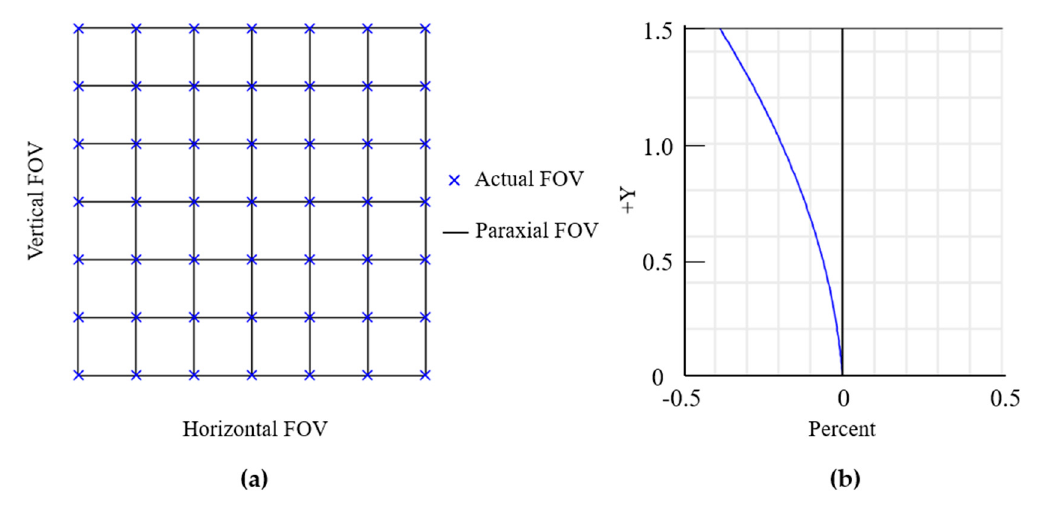
Figure 16. Distortion of the off-axis four-mirror system. ( a ) Grid distortion. ( b ) F-Tan (Theta) distortion.